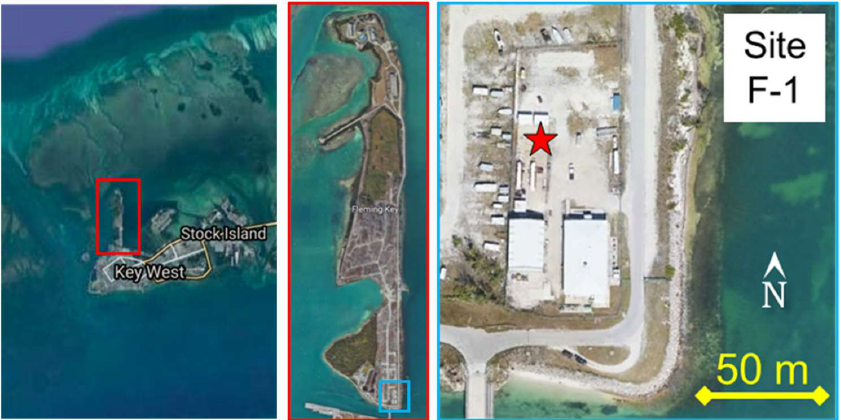
Figure 1. Overview of the NRL Key West exposure site. The red box on the left image becomes the area shown in the center image, the blue box on the center image becomes the right image, and the red star indicates where the samples were exposed.